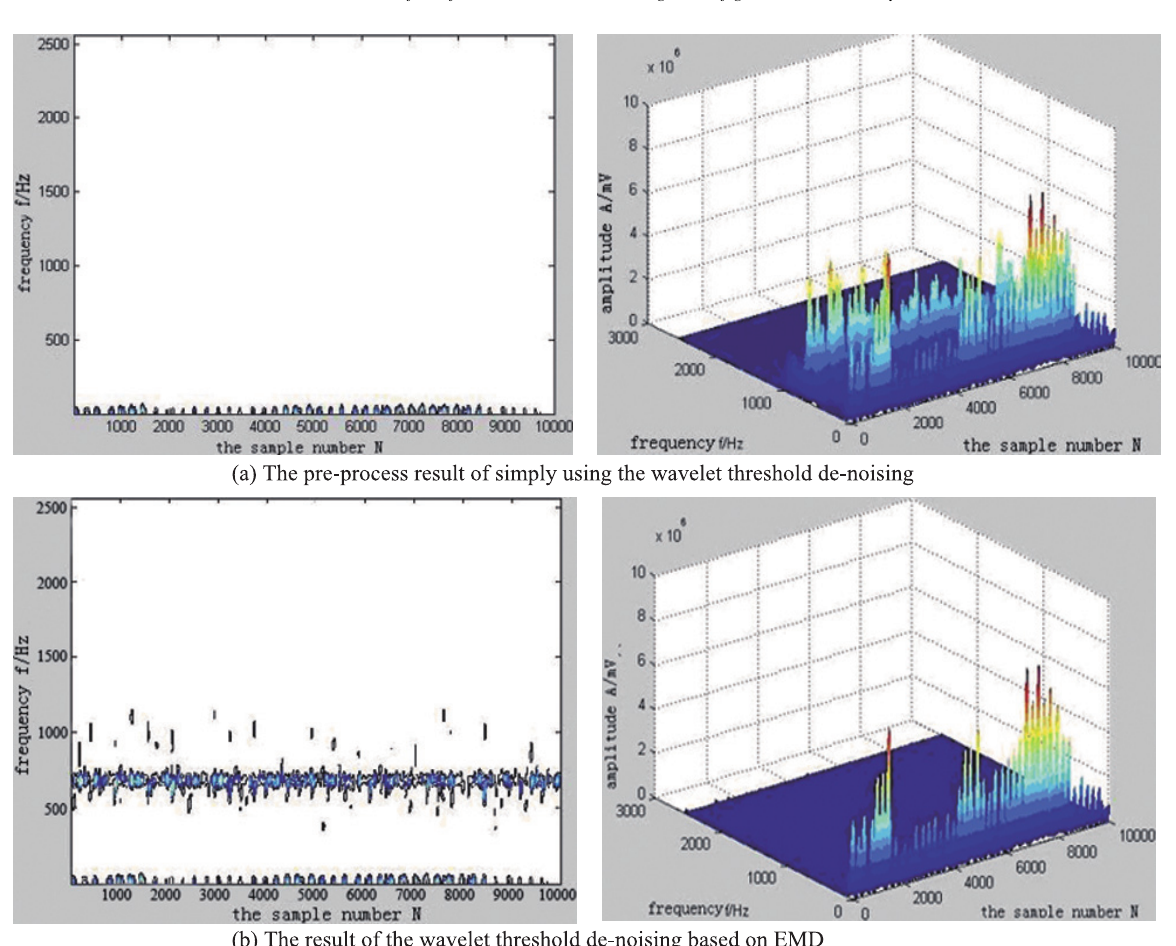
Fig. 4. The result of a time-frequency analysis for a tooth root crack fault signal at 900